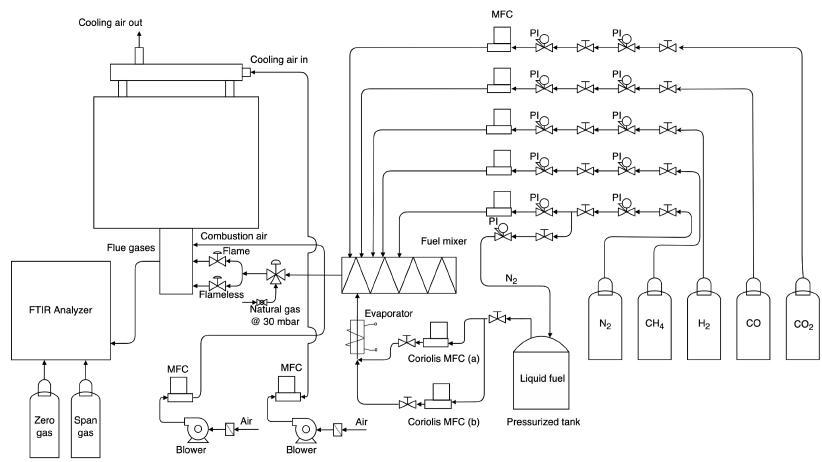
Figure 2. Schematic P & I of the ULB experimental test bench.